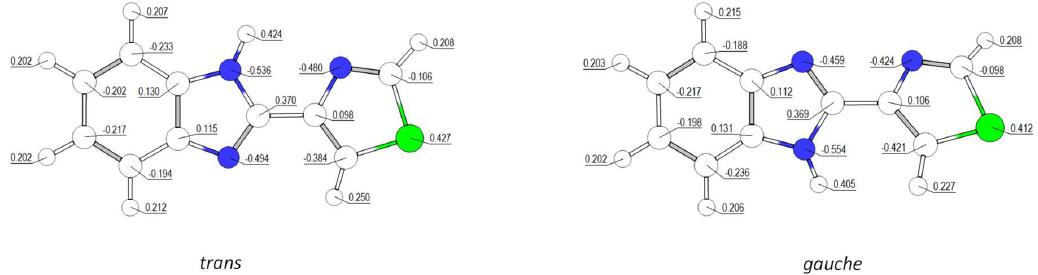
Figure 2. Natural atomic charges (in units of electron) on atoms for the two conformers of thiabendazole, as calculated at the B3LYP/6-311++G(2d,2p) level of theory. See Scheme 1 for atom numbering.